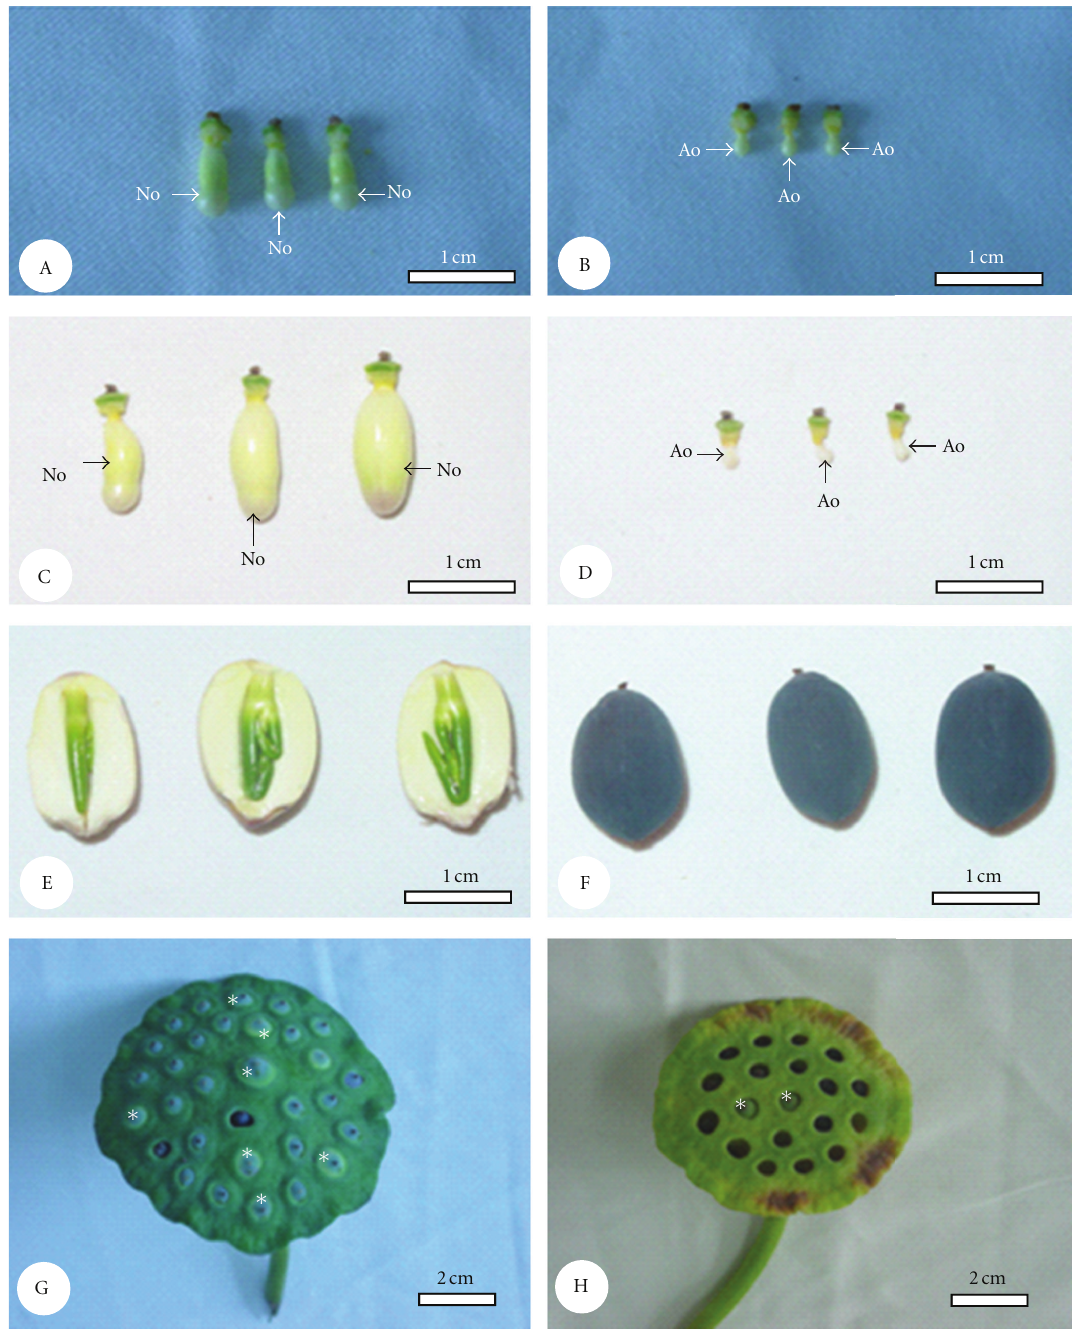
Figure 3: The morphology of lotus ovary, seed, and seed pod at di ff erent times after pollination. (A): Normal ovaries at 5d after pollination. (B): Abnormal ovaries at 5d after pollination. (C): Normal ovaries at 11 d after pollination. (D): Abnormal ovaries at 11d after pollination. (E): Seeds at 25 d after pollination. (F): Seeds at 30 d after pollination. (G): Lotus seed pod at 11 d after pollination in “Jinsenianhua” × “Qinhuaihuadeng” (asterisks indicate normal seeds). (H): Lotus seed pod at 11d after pollination in “Qinhuaihuadeng” × “Jinsenianhua” (asterisks indicate normal seeds). Abbreviations: Ao (abnormal ovary); No (normal ovary).